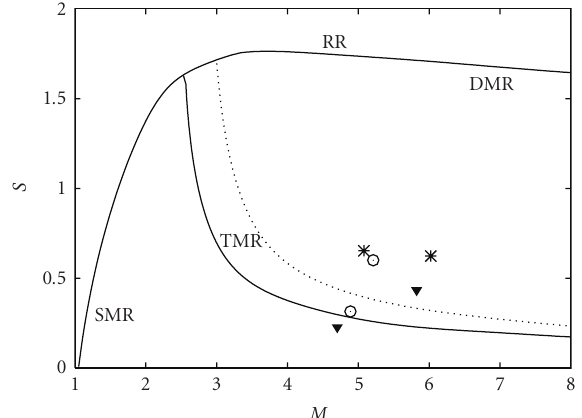
Figure 27: Transitionboundaries of shockwave reflection phenom- ena for the nonreactive H 2 :O 2 : Ar mixture at initially 298K and